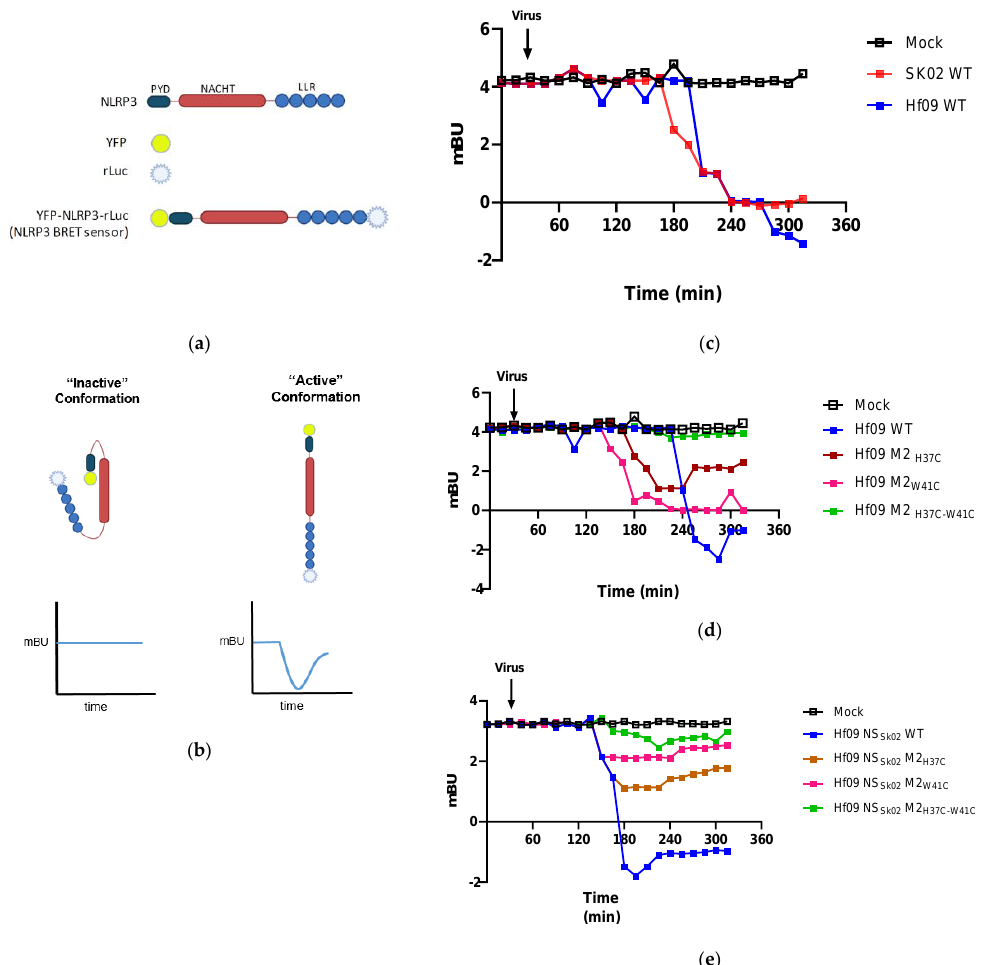
Figure 6. IAV induces NLRP3 conformational change upon infection. ( a ) Schematic representation illustrating the various components of the NLRP3 BRET sensor and ( b ) how the change in conformation of NLRP3 affects BRET signals (the two blue lines indicate BRET signals). HEK293T cells were transfected with pcDNA3.1- YFP-NLRP3-Luc for 24 h. The cells were then treated with Coelanterazine-h (5 μM). After 30 min, cells were infected with the following series of viruses at MOI of 1: Hf09 and Sk02 wild-type viruses ( c ) Hf09 virus and its derivatives containing M2 mutation ( d ), or Hf09 NS Sk02 virus and its derivatives containing M2 mutation ( e ). The signal was recorded every 15 min and BRET signal is expressed as mBU (milli-BRET unit). The black arrow represents when the virus was added.